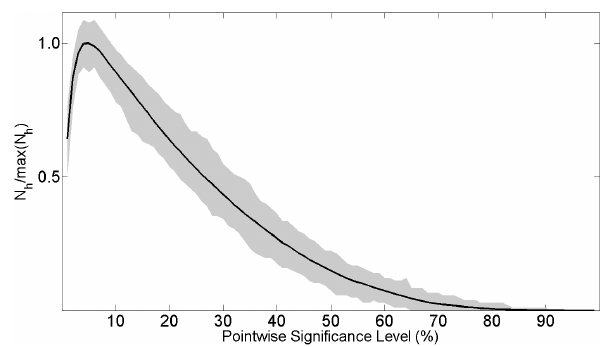
Figure 7. Normalized mean number of holes as a function of point- wise significance level. The number of holes was calculated by gen- erating 10000 synthetic wavelet power spectra of red-noise pro- cesses with fixed autocorrelation coefficients of 0.5 and computing the number of holes. Gray shading represents the 95% confidence interval.